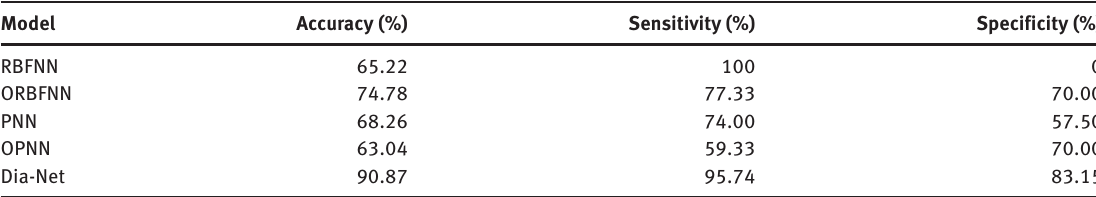
Table 5: Performance comparison of the proposed